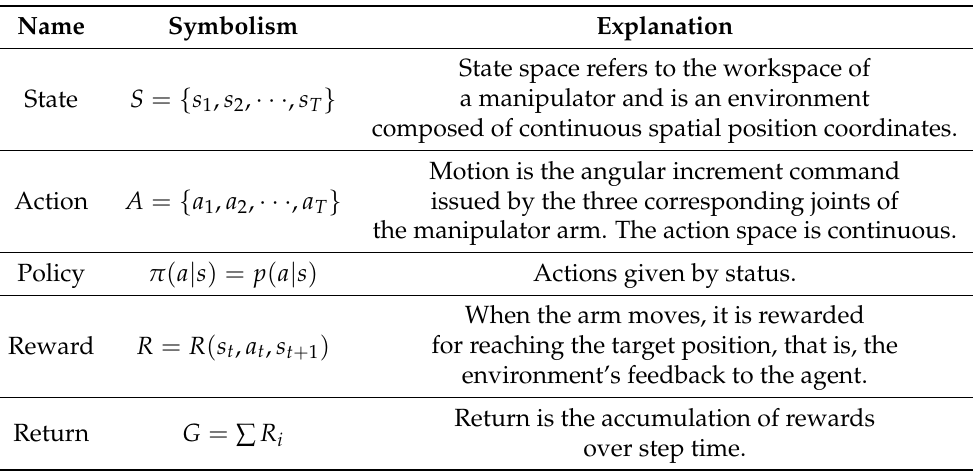
Table 1. Markov decision